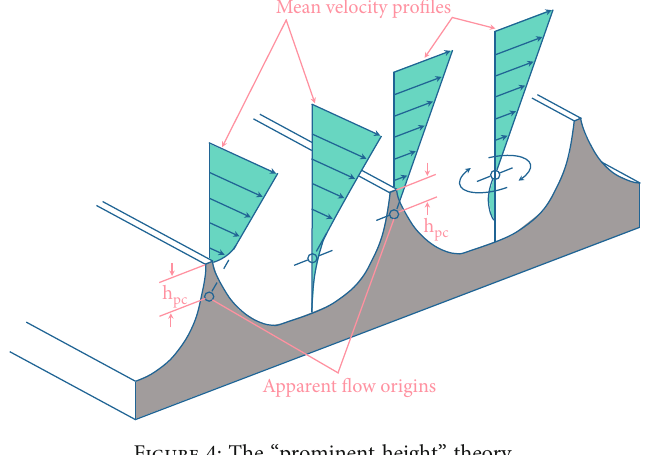
Figure 4: The “ prominent height ” theory.